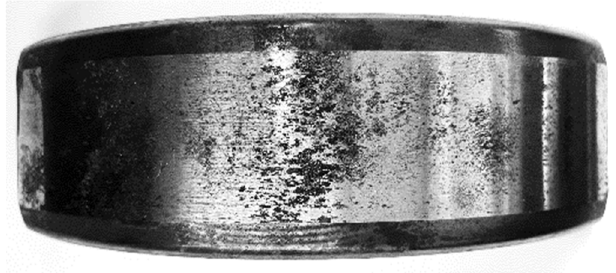
Figure 2. Material fatigue of a rolling bearing.